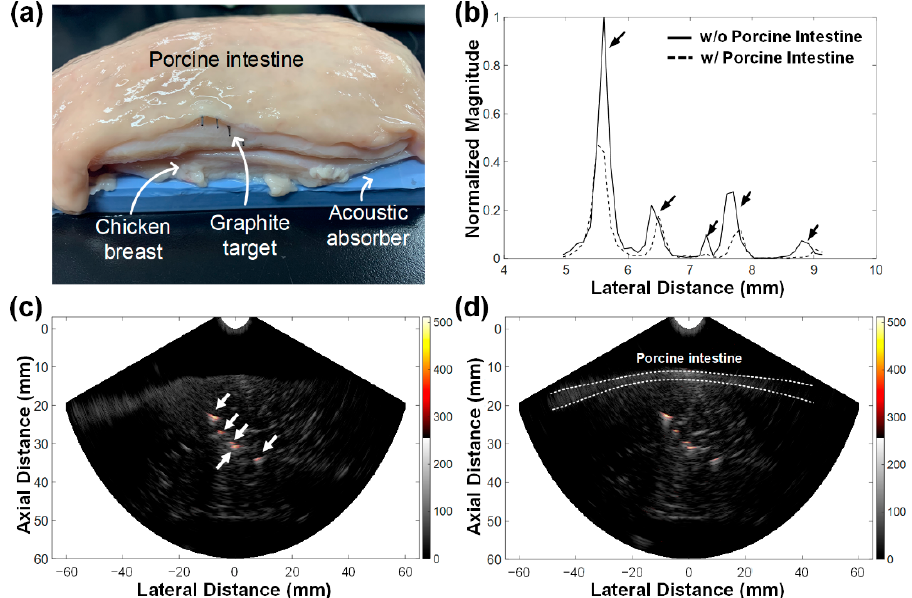
Figure A4. ( a ) Photograph of the imaging target used for the ex vivo experiments and ( b ) lateral beam profiles of the five graphite rods in the chicken breast tissue, without (solid line) or with (dashed line) the porcine intestine cover. ( c , d ) Combined ultrasound and photoacoustic images of the image target, ( c ) without and ( d ) with the porcine intestine cover. The US and PA images were logarithmically compressed with a dynamic range of 55 and 25 dB, respectively.